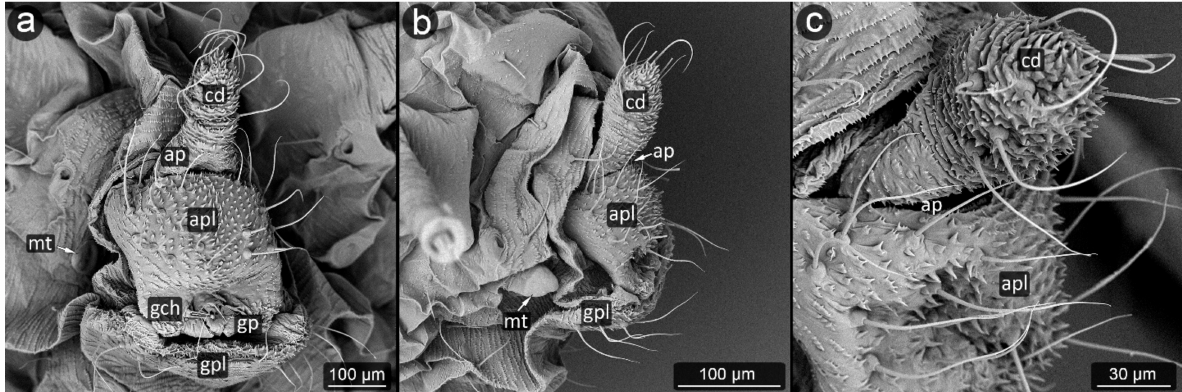
Figure 22. Perianal structure of Aphis fabae in SEM; ( a )—rear view, ( b )—lateral view, ( c )—close-up on the surface of cauda and anal plate. Aphis hederae Kaltenbach, 1843 (Figure 23).